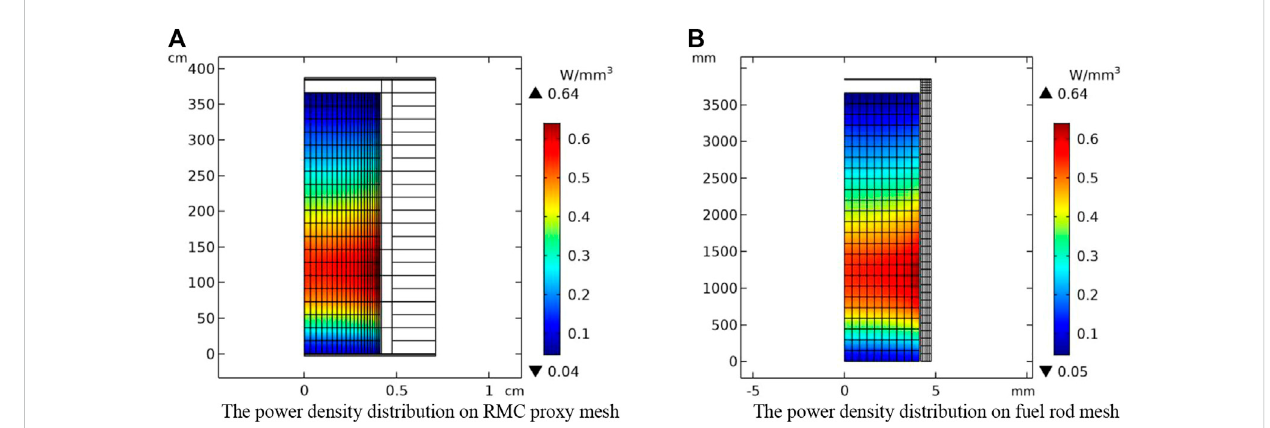
FIGURE 2 Power density distribution on RMC proxy mesh (A) and fuel rod mesh (B) .